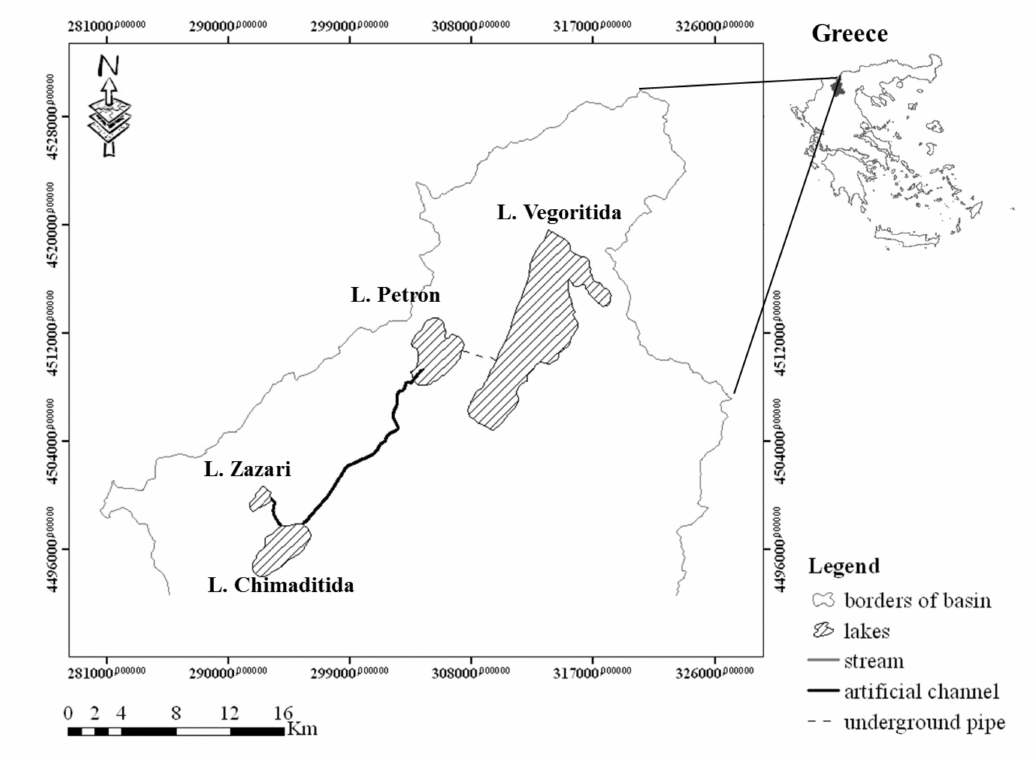
Figure 2. Map of the four studied lakes (Zazari, Chimaditida, Petron, and